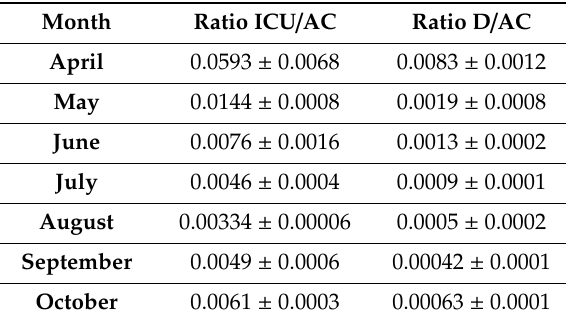
Table 1. Ratios ICU / AC and D / AC. Indicated uncertainties are statistical errors computed at 95% probability level (2).